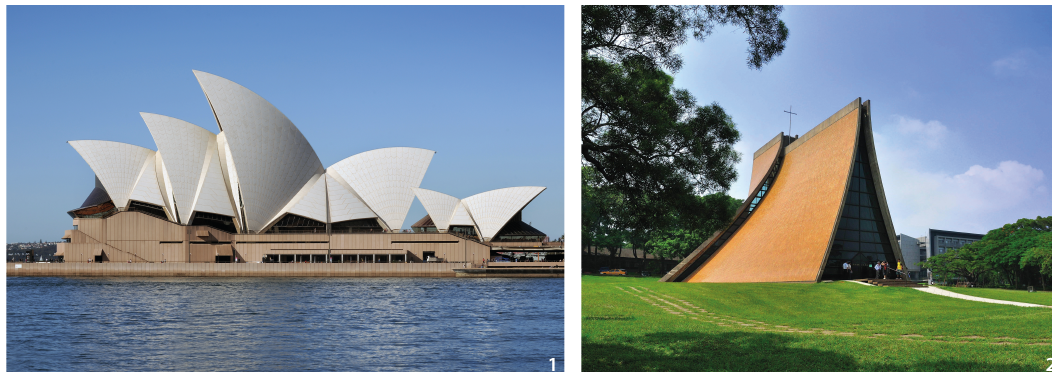
Figure 2 Henry Luce Memorial Chapel (Source: Tunghai